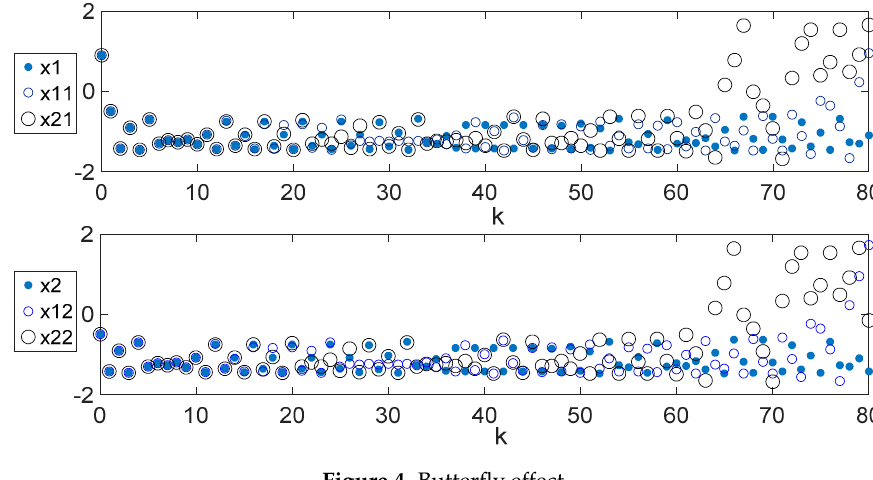
Figure 4. Butterfly effect.